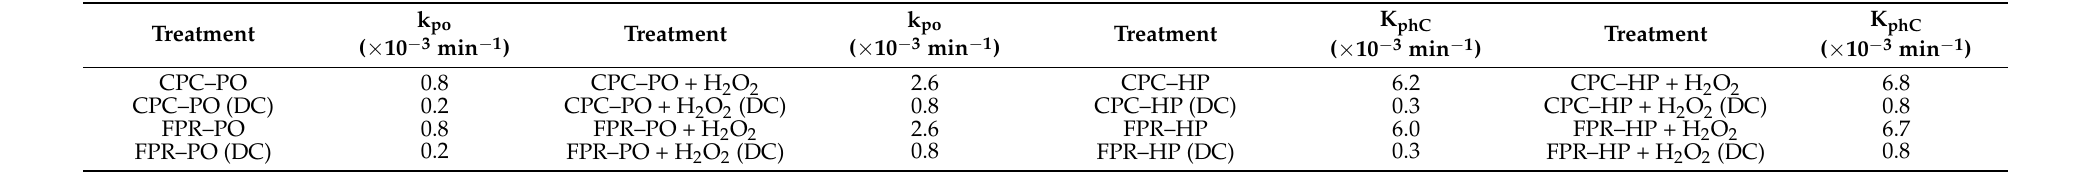
Table 6. Calculated photooxidative and photocatalytic reaction rate constants for arsenic